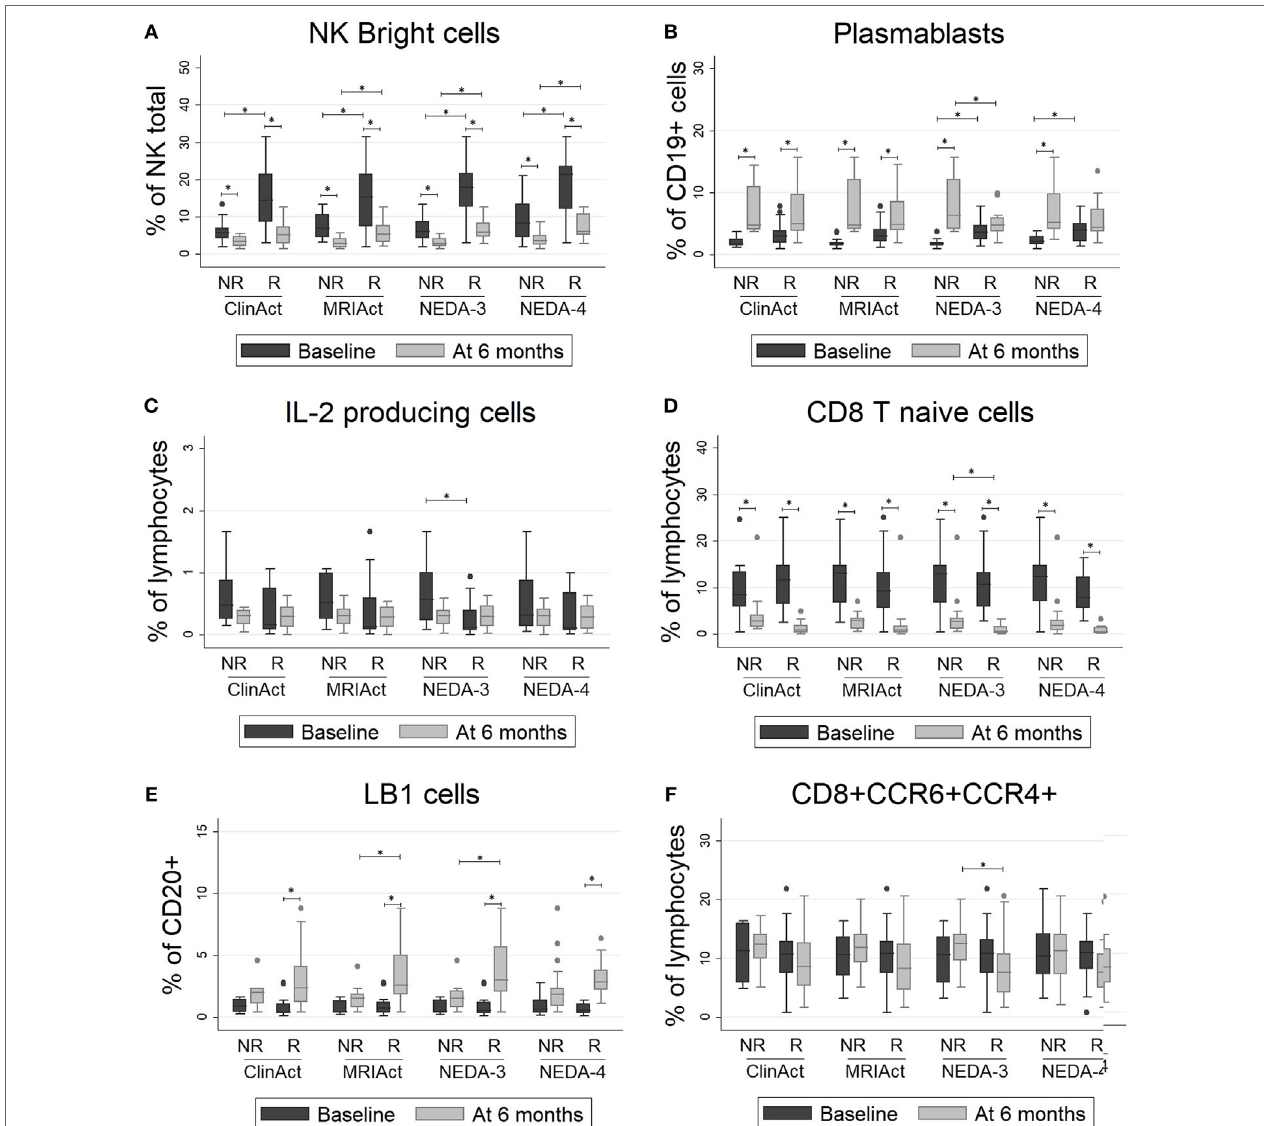
FigUre 2 | ( a–F ) Lymphocyte subpopulations with significant differences between responder (R) and non-responder (NR) patients: NK bright cells, plasmablasts, IL2-producing cells, CD8 T naïve cells, LB1 cells and CD8+CCR6+CCR4+ cells. The percentages of lymphocyte subpopulations at baseline and at 6 months of treatment are shown for different subgroups according to clinical response by four different measure ways: ClinAct: clinical activity (NR = clinical activity present, R = clinical activity absent); MRIAct: radiological activity (NR = radiological activity present, R = radiological activity absent); NEDA-3 (NR = no evidence of disease activity by NEDA-3 criteria, R = evidence of disease activity by NEDA-3 criteria); and NEDA-4 (NR = no evidence of disease activity by NEDA-4 criteria, R = evidence of disease activity by NEDA-4 criteria). The p -values were calculated using the Wilcoxon signed-rank test to compare differences before and after 6 months of therapy and using Mann–Whitney test to compare differences between subgroups. p < 0.001 was considered statistically significant after Bonferroni’s correction for multiple